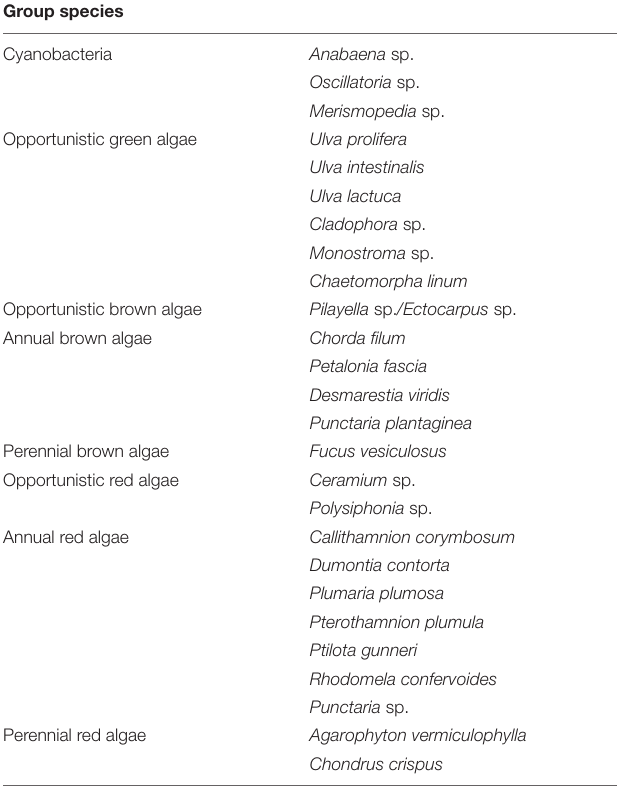
TABLE 1 | List of identified cyanobacterial and macroalgal species divided into opportunistic, annual, and perennial